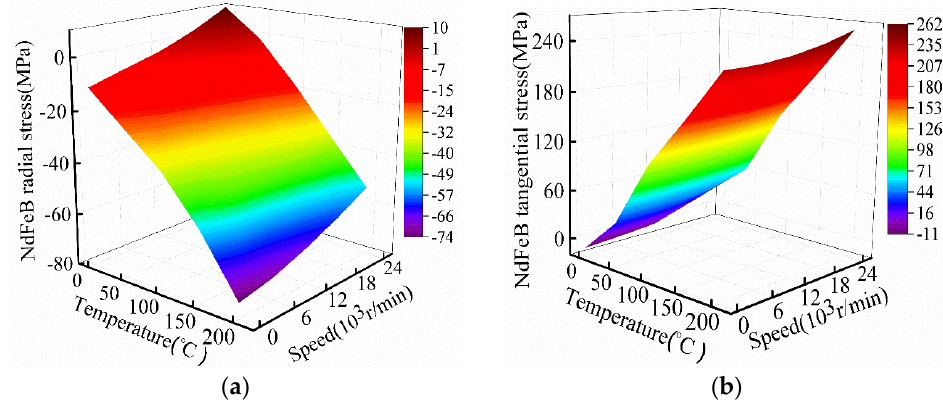
Figure 16. Influence of temperature and speed on NdFeB-PM stress. ( a ) NdFeB based radial stress; ( b ) NdFeB based tangential stress.